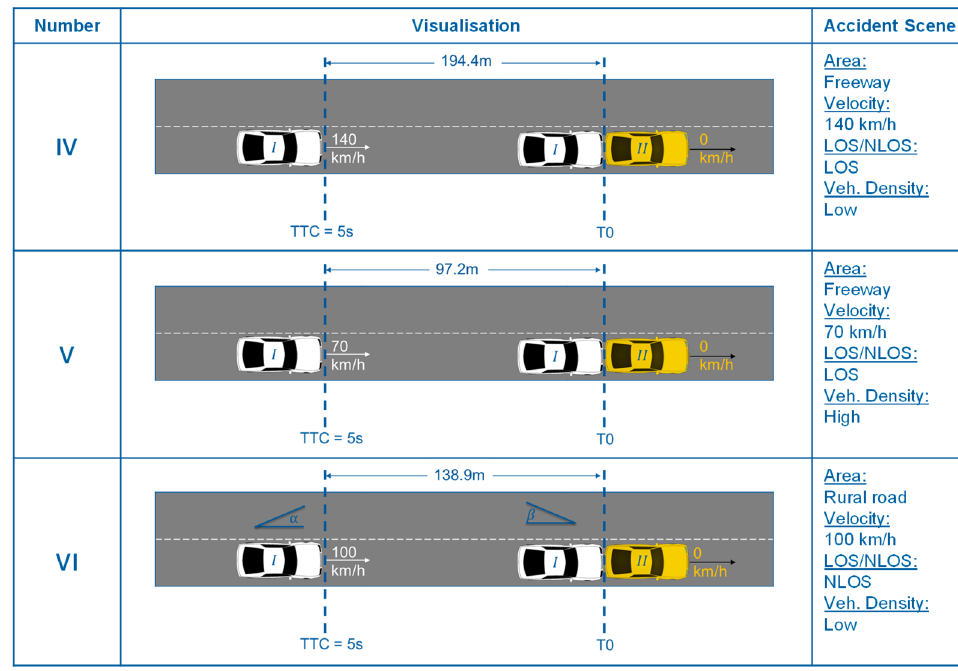
Figure 6. Illustration of the investigated “worst-case” rear-end crash scenarios (20–23).